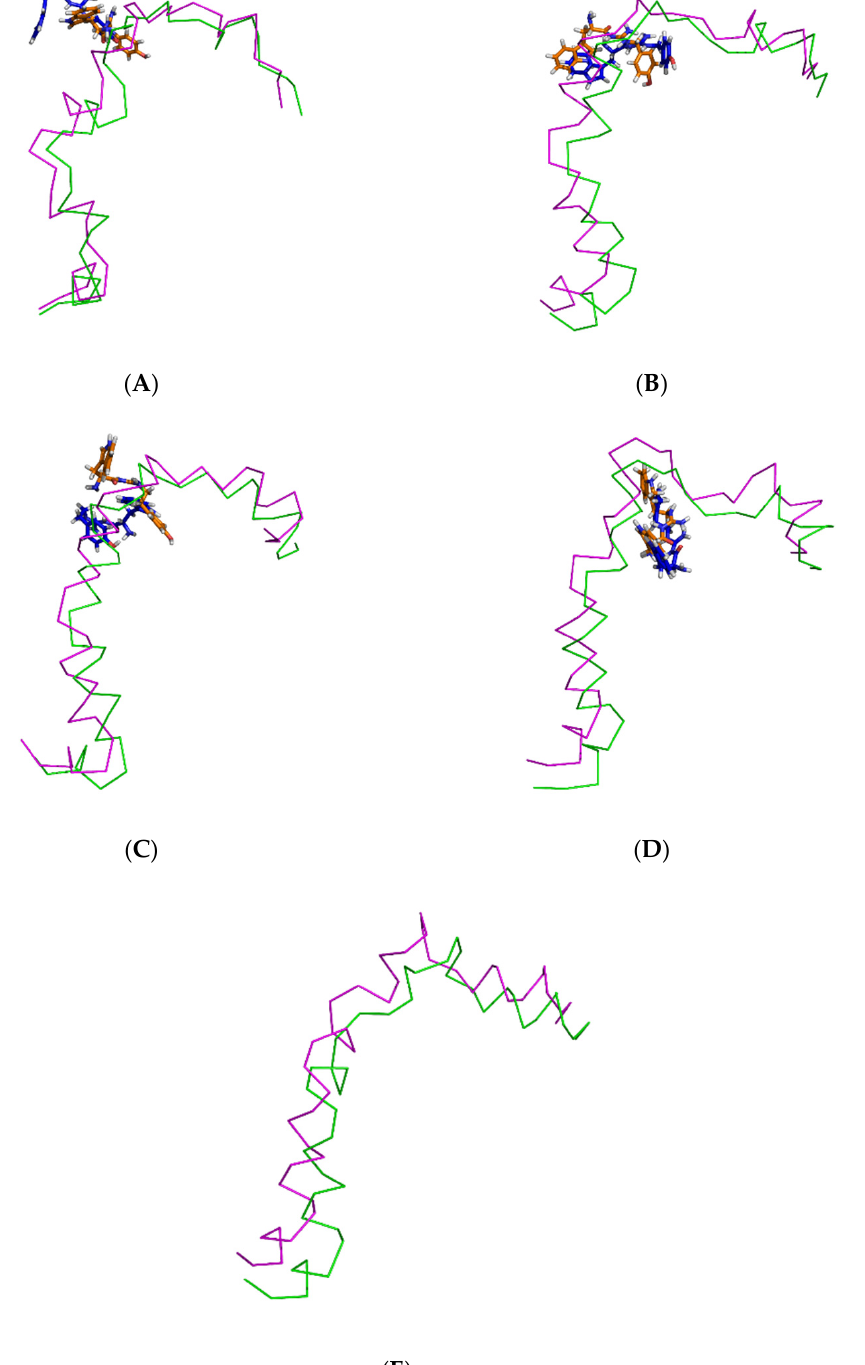
Figure 4. Superimposition of the pre- and post-MD simulation structures of the A β 1–42 monomer shown in ribbon representation (magenta and green, respectively) and the pre- and post-MD simulation structures of each ligand shown as a stick representation (orange and blue color, respectively). The systems include ligands ( A ) TGN1, ( B ) TGN2, ( C ) TGN3, and ( D ) TGN4, as well as ( E ) no ligand (only the A β 1–42 monomer).